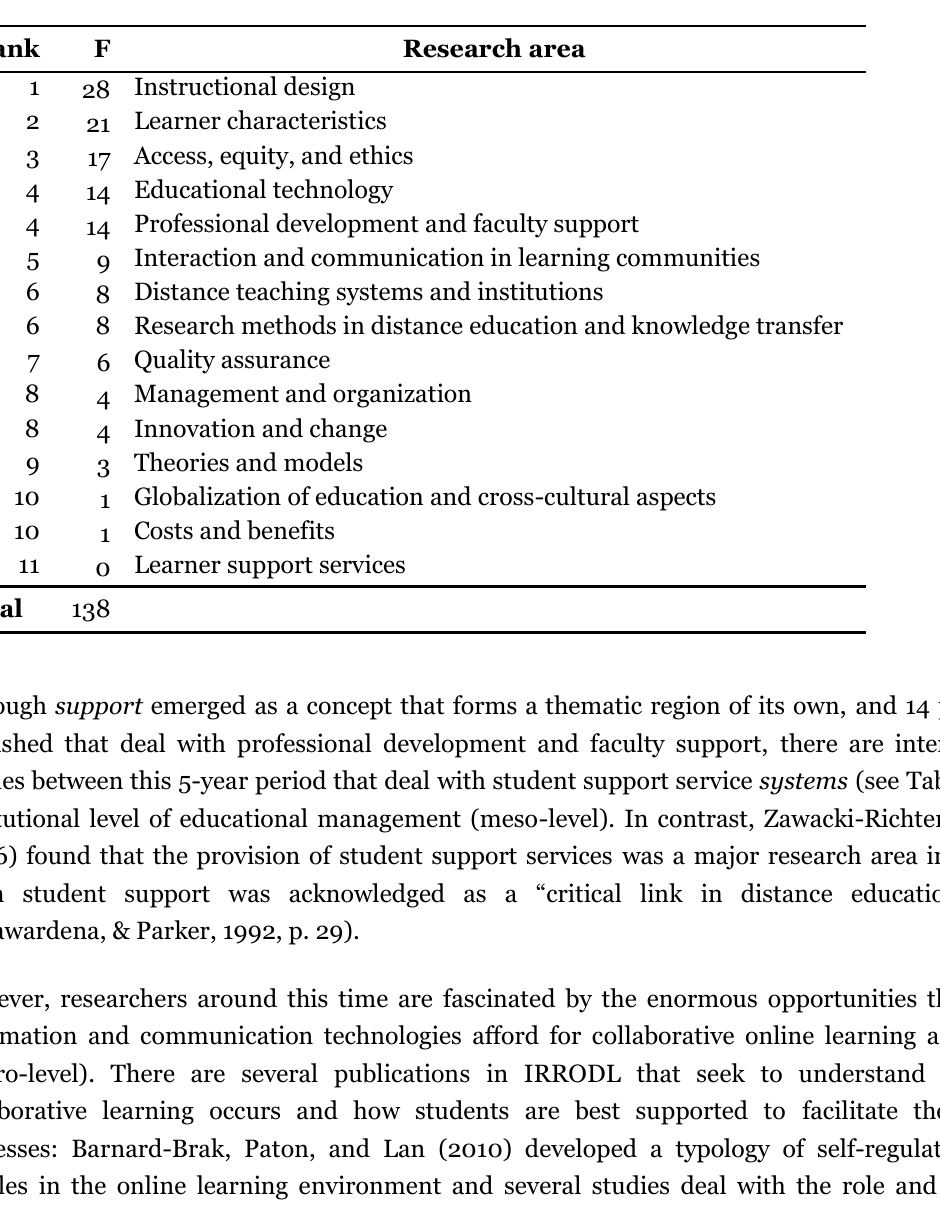
Distribution of Research Areas from 2006–2010 (N =